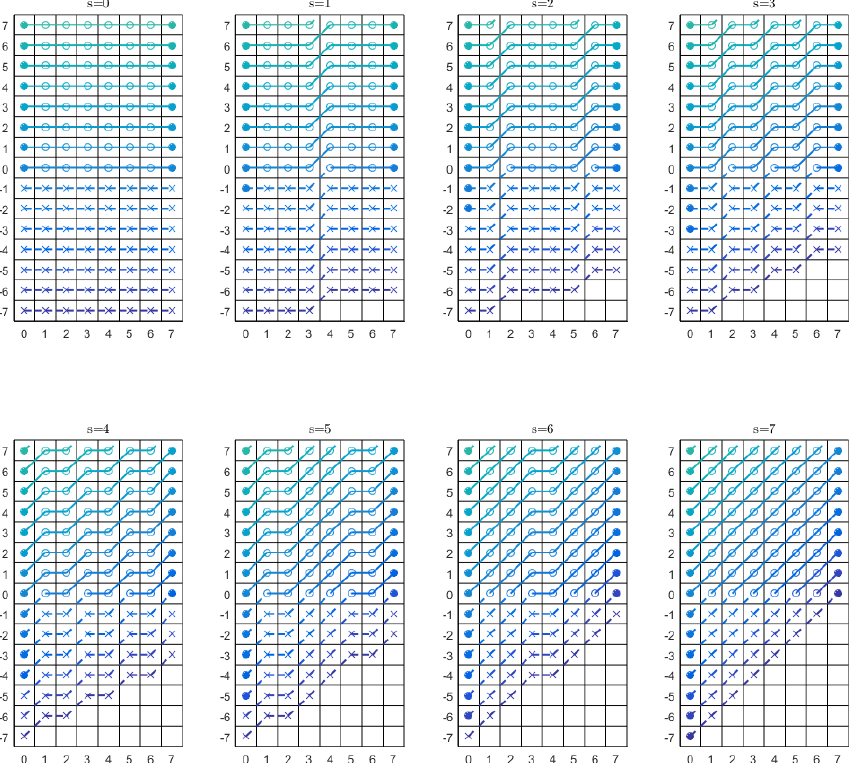
Figure 5. A depiction of the whole set of discrete lines covering the displacements and slopes, as computed by conventional